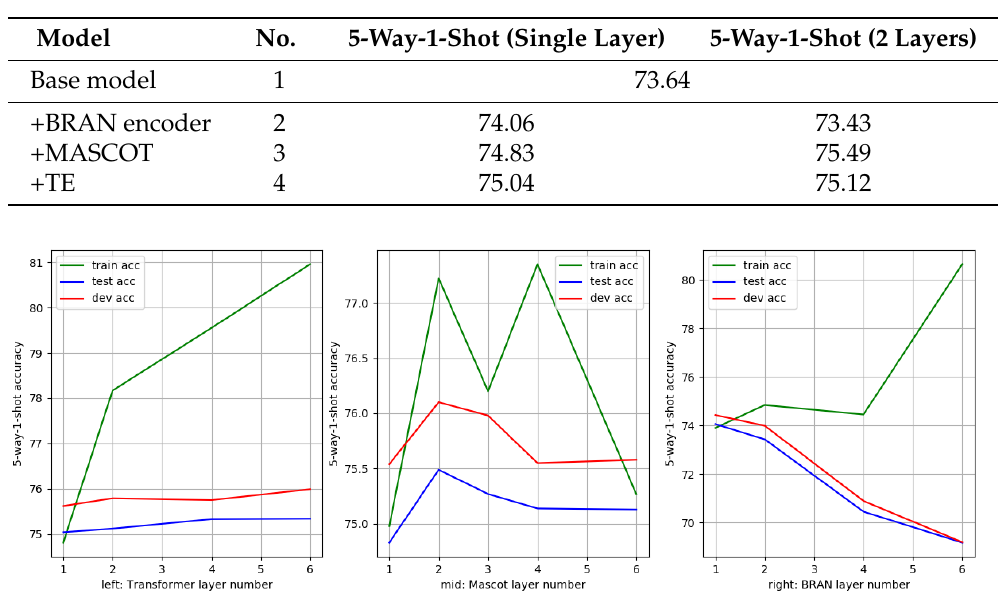
Figure 5. Comparison of the different model depth